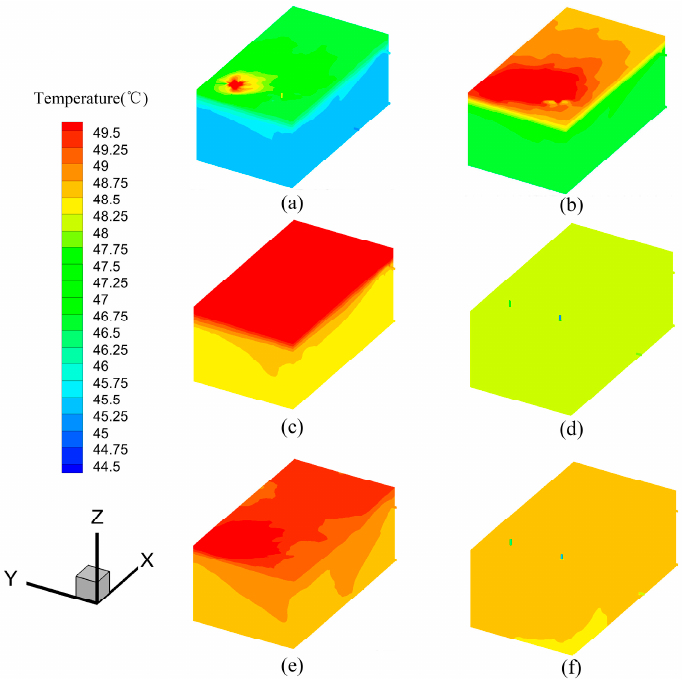
Figure 8. Temperature distribution of the heat storage tank (profile): ( a ) 12:00; ( b ) 13:00; ( c ) 14:00; ( d ) 15:00; ( e ) 16:00; ( f ) 17:00.